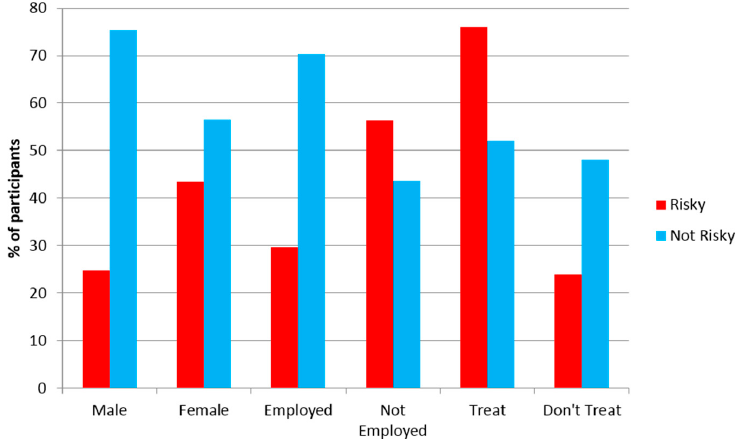
Figure 3. Risk perception by sex, employment status and water treatment. Table 4. Significant chi-squared results for relationships associated with risk perception. Risk Perception vs.